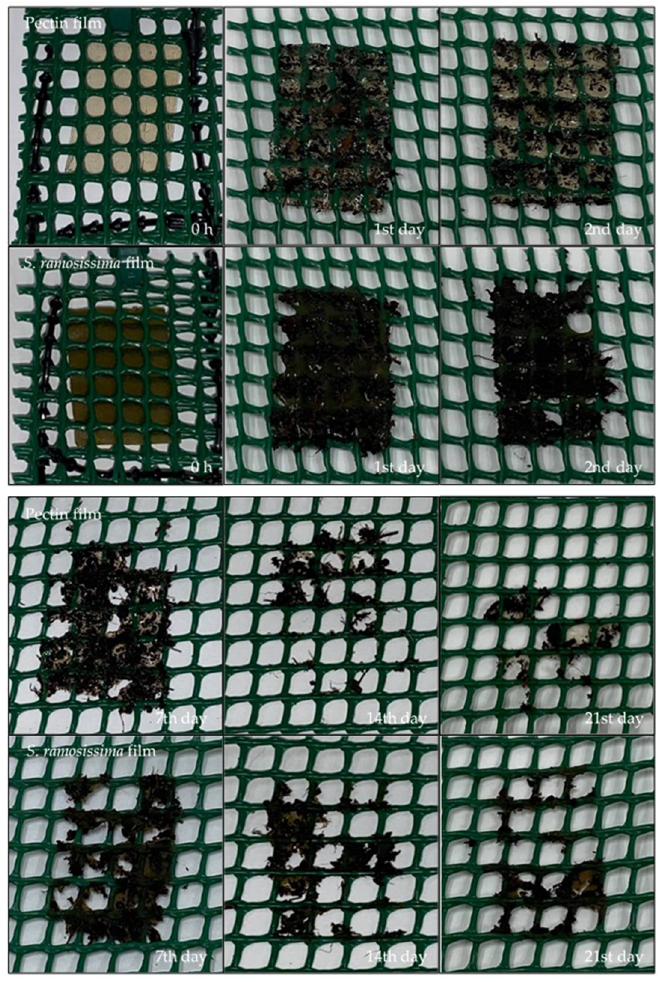
Figure 5. Biodegradation test in soil.